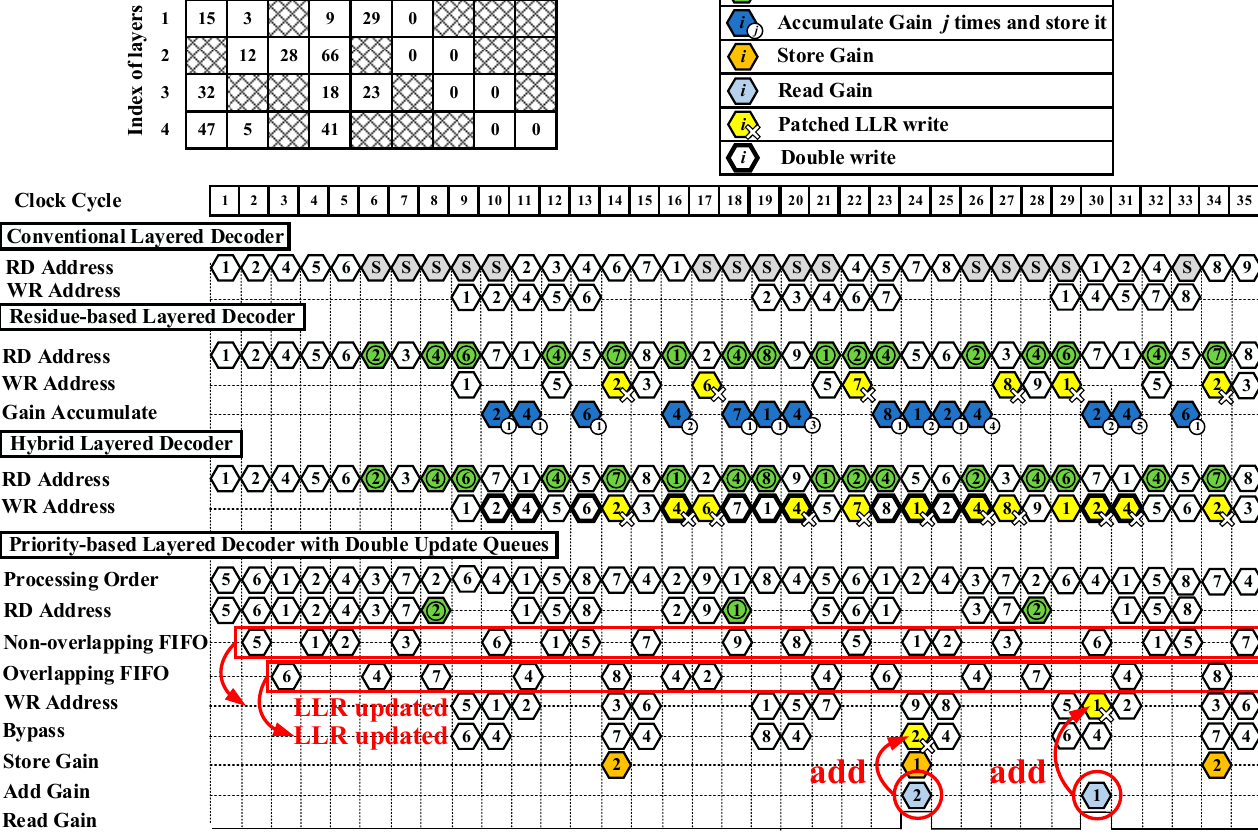
Figure 4. Illustration of the priority-based layered decoder with double update queues compared with the conventional layered decoder, the residue-based decoder and the hybrid decoder. The number of pipeline stages is set to 3.